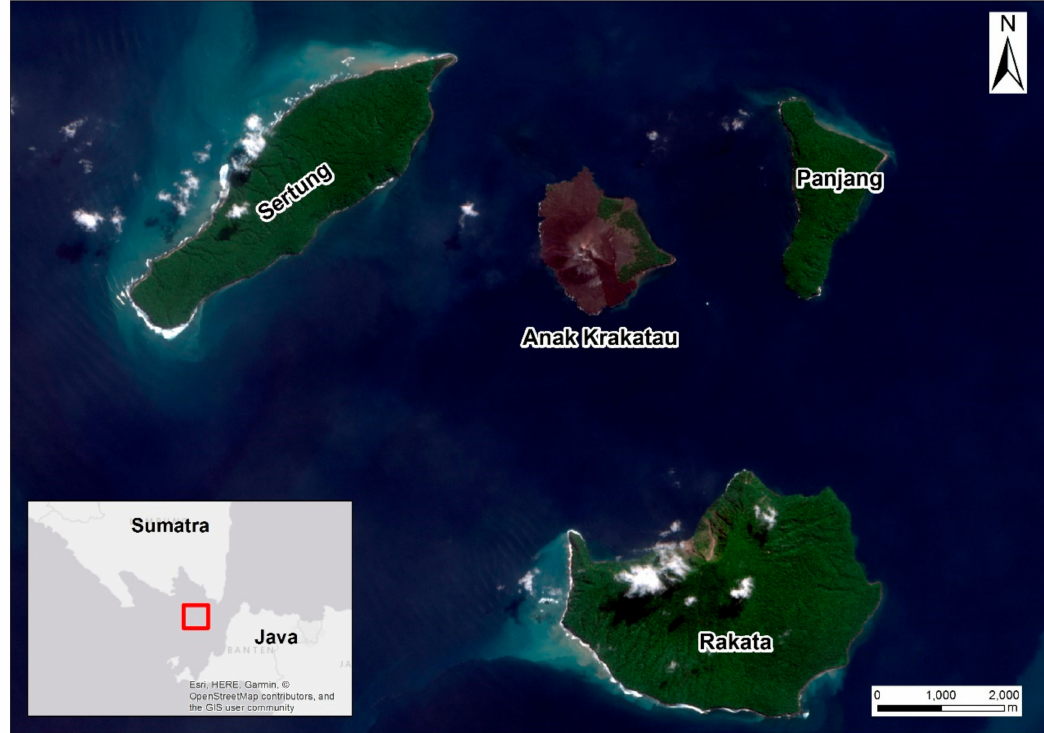
Figure 1. Location of the Anak Krakatau archipelago from true color composite image of Sentinel-2 captured on 15 August